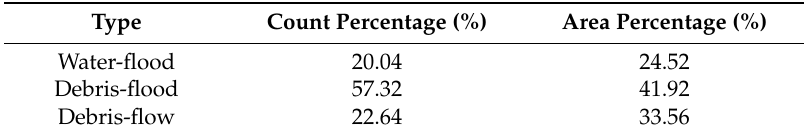
Table 4. Catchment type classification.